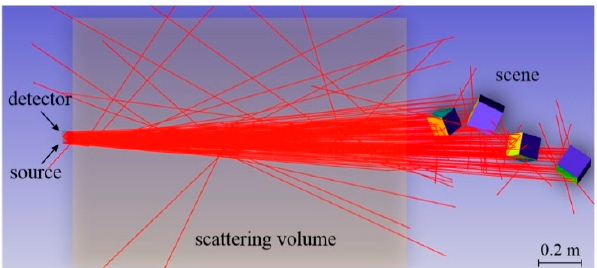
Figure 1. Zemax model of the ToF sensor in front of a scene consisting of several cubes with scattering surfaces. The sensor is composed of a source and a detector, formed by a paraxial lens, a round aperture and a detector. The scattering medium is described by a Mie model, and restricted to a volume located between the sensor and the